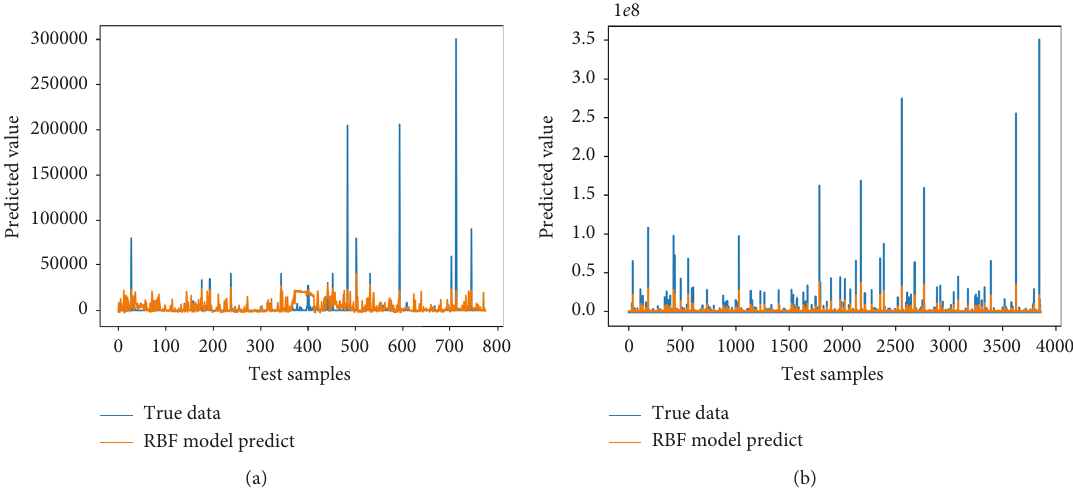
Figure 8: Testing performance of SVR on (a) UCI seismic bumps and (b) AAIA ′ 16 seismic.